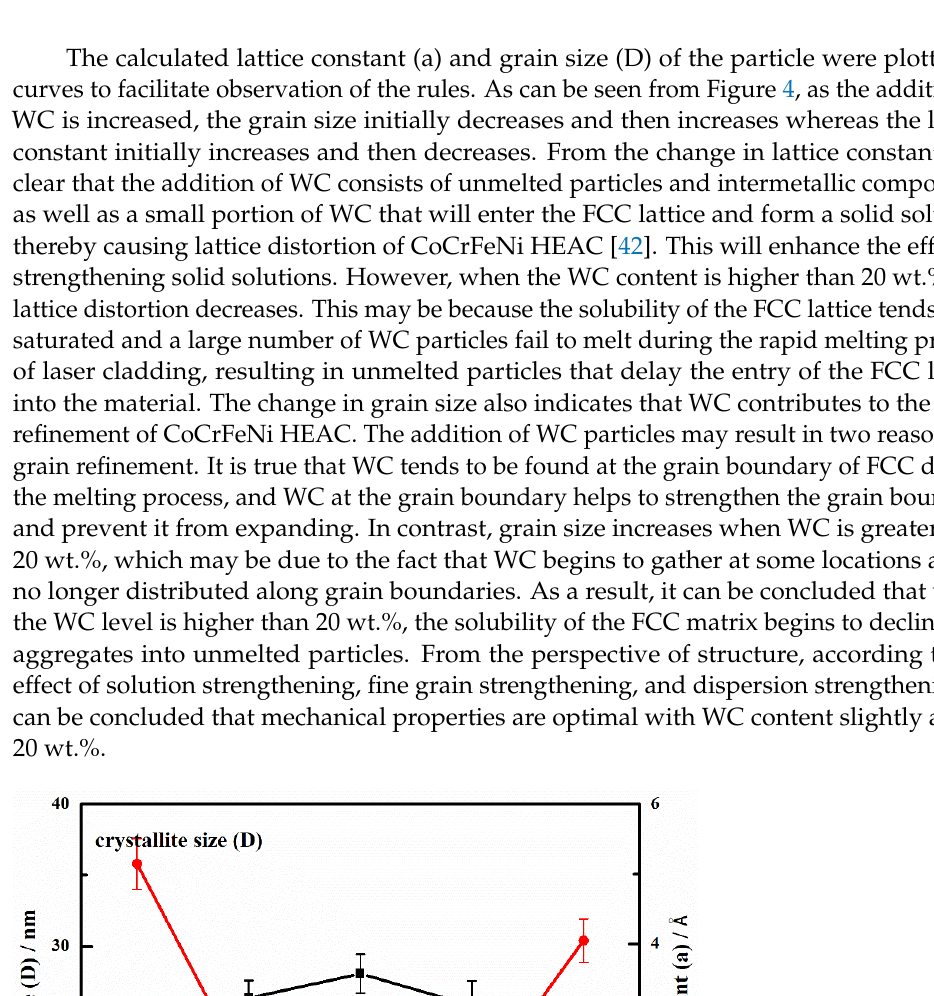
Figure 5. Cross ‐ sectional FESEM images of coatings: ( a ) CoCrFeNi HEAC; ( b ) CoCrFeNi HEACC (10 wt.% WC); ( c ) CoCrFeNi HEACC (20 wt.% WC); ( d ) CoCrFeNi HEACC (30 wt.% WC); ( e ) CoCrFeNi HEACC (40 wt.% WC).